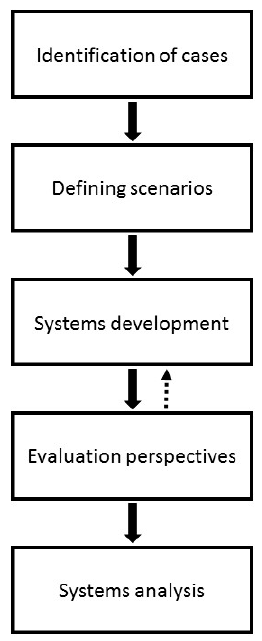
Figure 1. A schematic picture of the developed research design.